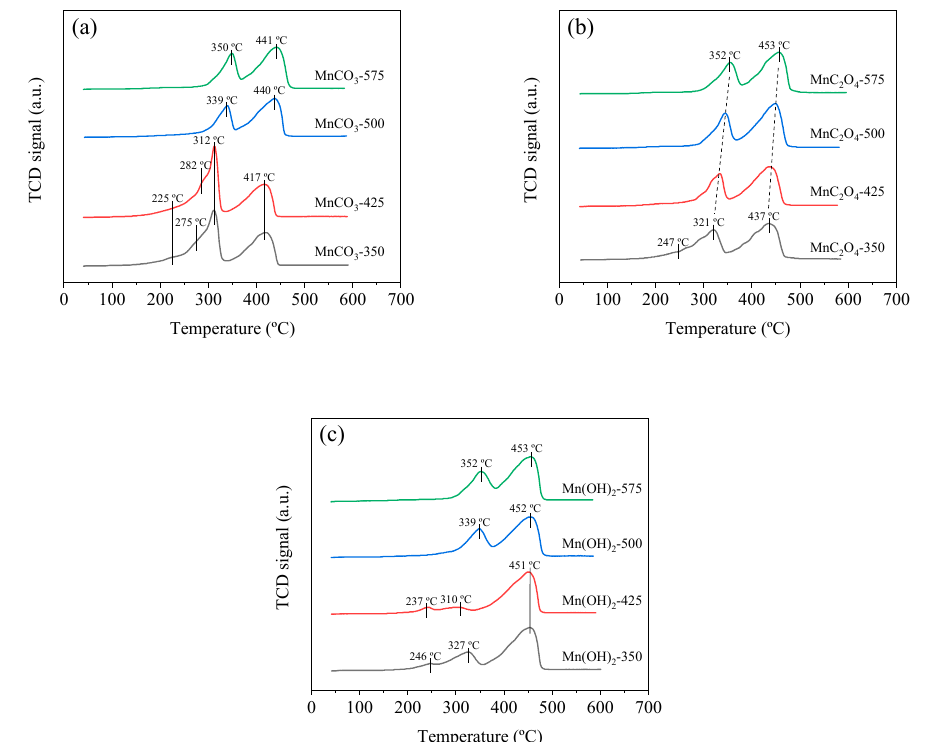
Figure 4. H 2 -TPR profiles of the manganese oxide catalysts obtained by calcining ( a ) MnCO 3 , ( b ) MnC 2 O 4 and ( c ) Mn(OH) 2 .